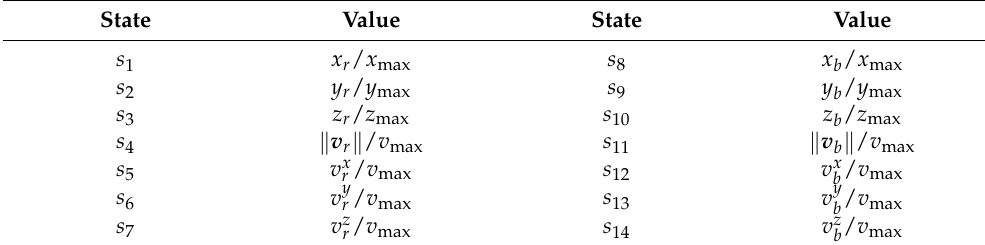
Table 2. State observation space.